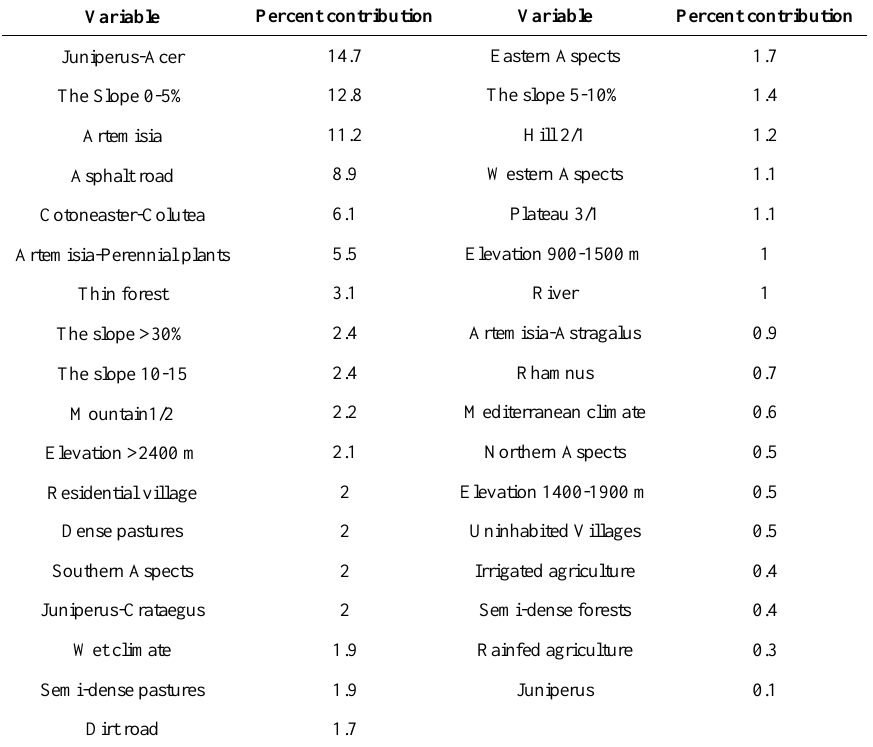
Table 1. Percent contribution values of variables used in modeling